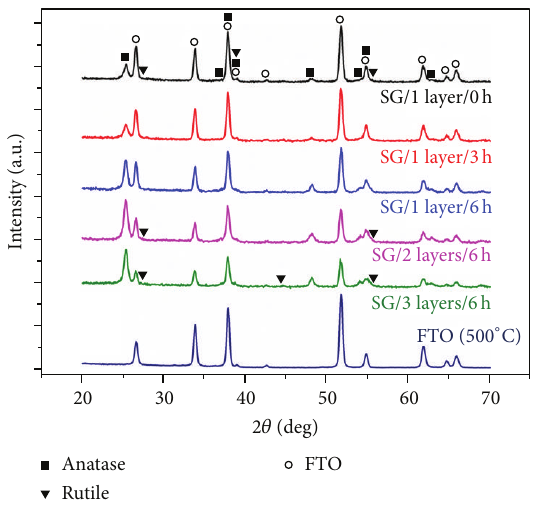
Figure 2: GA-XRD analysis of the different TiO 2 sol-gel photoelec- trodes. The crystallinity of aged sol-gel is improved in comparison with the gel without aging (0 h). Anatase is the dominant phase in all the photoelectrodes, although a small amount of rutile is also present.